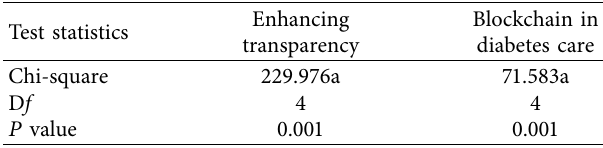
Table 4: Chi-square test between safety of information and the usage of blockchain in diabetes care for elderly patients.